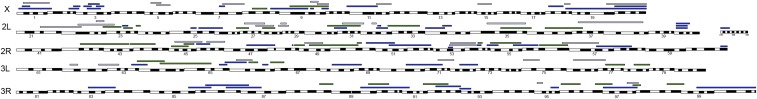
Deficiency mapping of hybrid incompatibilities in the D. santomea genome at two different temperatures. Light blue: hybrid inviability only at 18°. Green: hybrid inviability only at 24°. Dark blue: hybrid inviability at both temperatures. Deficiencies not causing hybrid inviability are not shown.